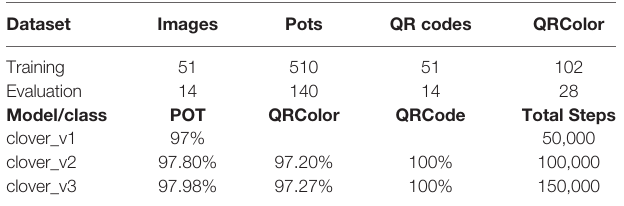
TABLE 2 | Bounding box accuracy (PASCAL VOC AP@0.5IoU Everingham et al., 2010) measured on 14 testing images. Dataset